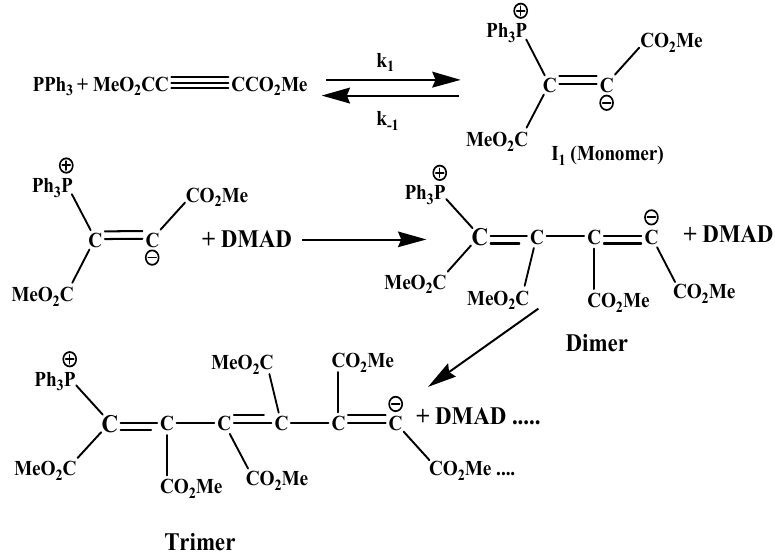
Scheme 1. The reaction between TPP and DMAD.